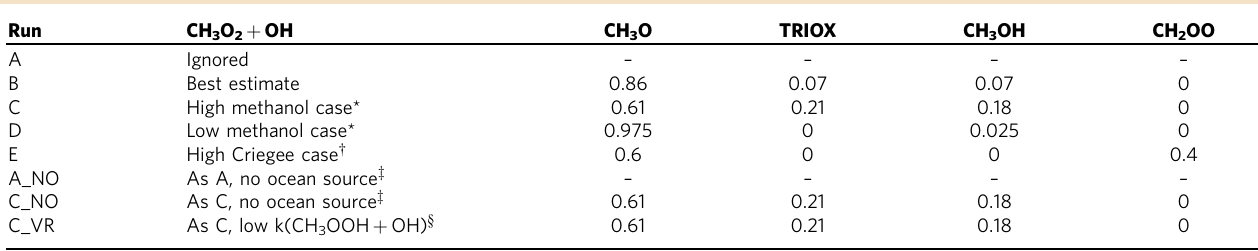
Table 4 | Overview of model simulations with assumed product